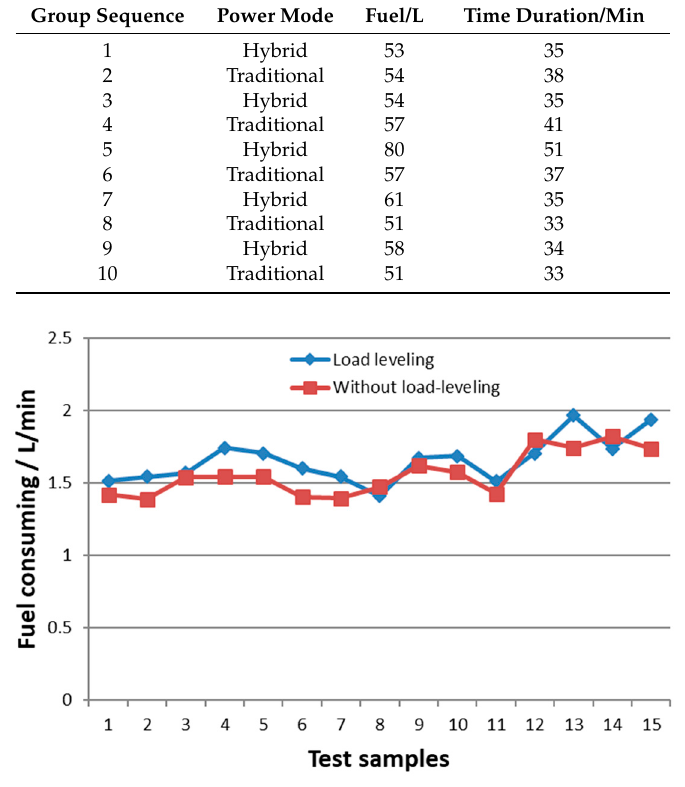
Figure 19. Fuel consumption in comparison.